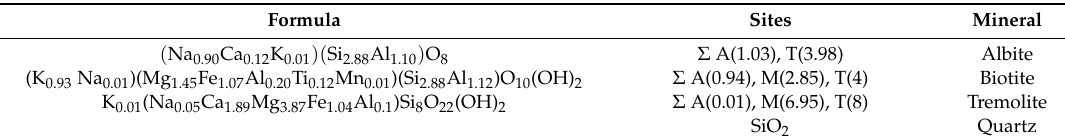
Table 4. The average mineral compositions from the trondhjemite (see Figure